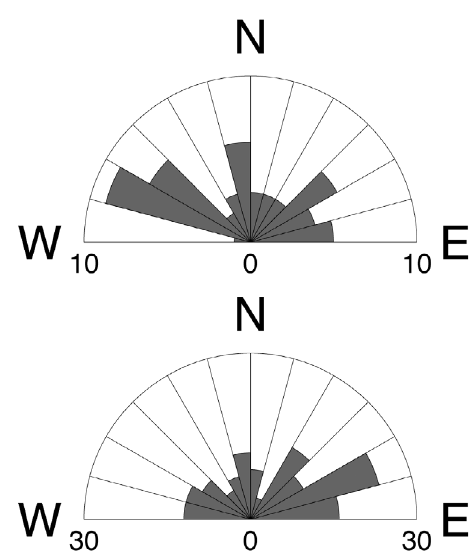
Figure 13. Rose diagram showing the distribution of strike values of the focal mechanisms. The graphic on the top is for events lo- cated a.s.l. while the one on the bottom is for the other events. Each sector is 15° wide and the outer edge of the graphics corresponds to a value of 10 events for the top and 30 for the bottom.